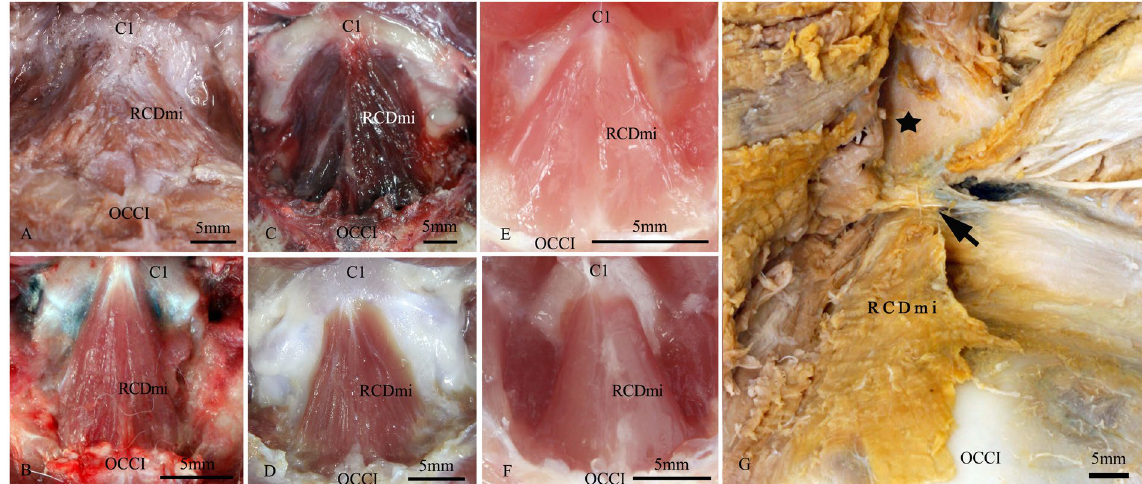
Figure 2. The RCDmi of the five mammalian orders of mammals showed when the RCDma removed (antero-superior view). ( A ) Macacamulatta . ( B ) Oryctolaguscuniculus . ( C ) Canisfamiliaris . ( D ) Feliscatus . ( E ) Ratusnorvegicus . ( F ) Caviaporcellus . ( G ) Indoasian finless porpoise . The RCDmi was originated from the dorsal arch of the atlas (C1) and inserted into the occipital bone (OCCI) in Macacamulatta , Oryctolaguscuniculus , Canisfamiliaris , Feliscatus , Ratusnorvegicus , Caviaporcellus . While the RCDmi of Indoasian finless porpoise was originated from the occipital bone (OCCI) and extended into the posterior atlanto-occipital interspace ( ↑ ). ★ : The fused spinous process. RCDmi: the rectus capitis dorsal